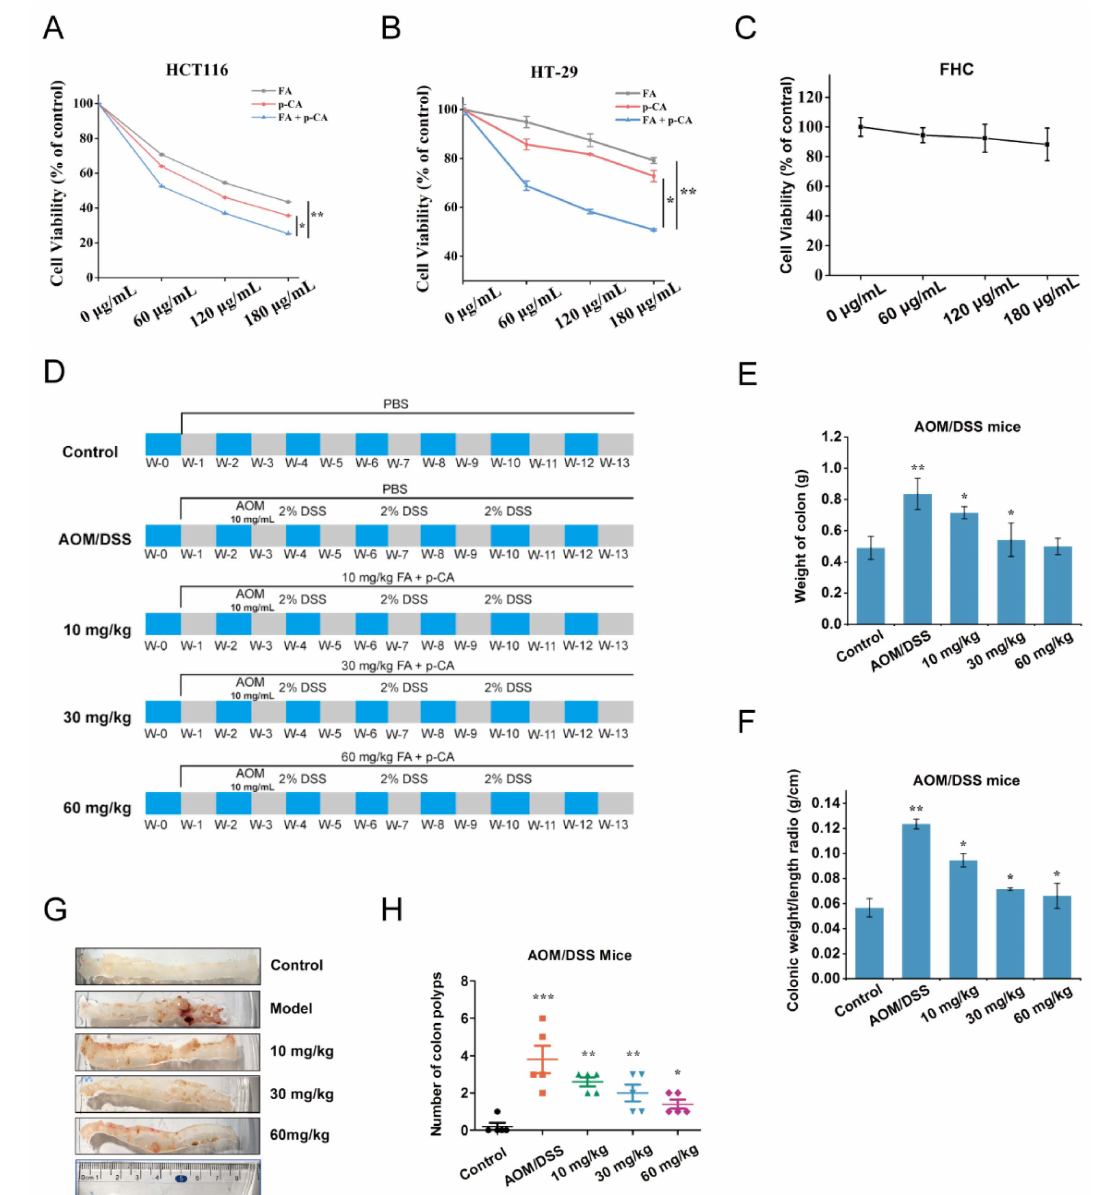
Figure 1. FA + p-CA inhibit the growth of colorectal cancer in CRC cells and AOM/DSS CRC mice. ( A – C ) The HCT116 ( A ), HT-29 ( B ) and FHC ( C ) cells were respectively exposed to increasing concentrations of FA, p-CA, and FA + p-CA for 48 h, the cell viability was then detected using MTT. The content ratio of p-CA and FA in the FA + p-CA was 1:1.13. ( D ) An overview of the experimental design of the AOM/DSS mice model. The mixture of FA + p-CA was intra-gastrically administered, and the content ratio of p-CA and FA was 1:1.13. ( E ) Weight of the colorectal in different groups in the 14th week was recorded. ( F ) Colonic weight/length ratio in different groups was detected. ( G ) Macroscopic structure findings of the colon in different groups. ( H ) Tumor numbers in the colon in different groups were annalistic. Data are represented as means ± SD ( n ≥ 5). Compared to control, * p < 0.05, ** p < 0.01, *** p <